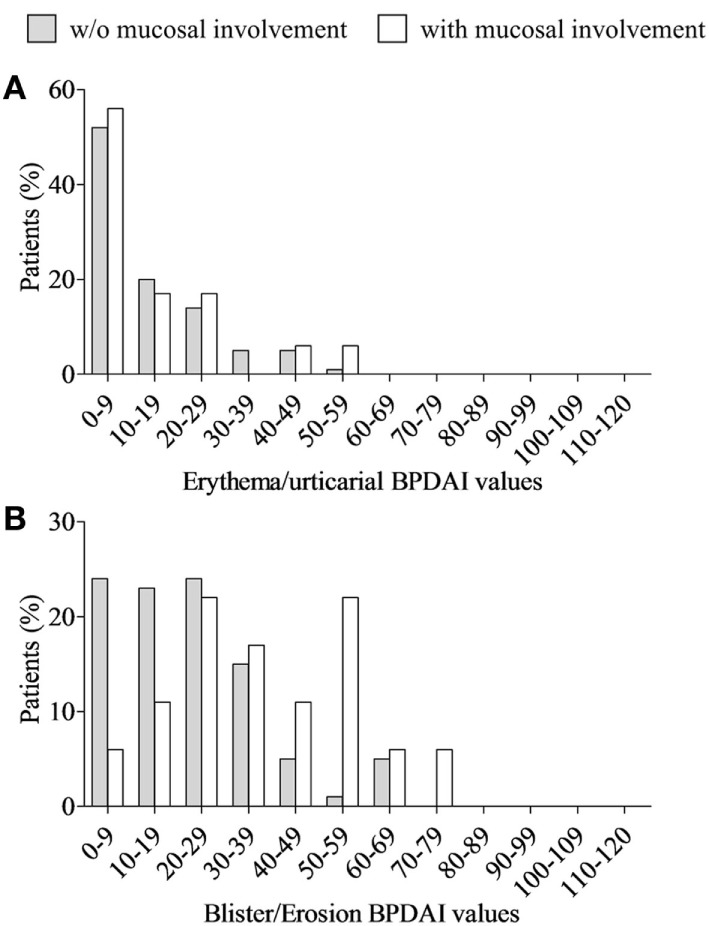
Distribution of both bullous pemphigoid (BP) patients with (white column) and without (gray column) mucosal involvement according to erythema/urticaria BP Disease Area Index (BPDAI) values (A) and blisters/erosions BPDAI values (B) at the time of diagnosis. No statistical differences were observed between the distributions of these two BP groups according to the Kolmogorov–Smirnov test, although a clear different distribution could be visualized within the low (0–19) and within the high (50–79) values of the blisters/erosions BPDAI values (B).